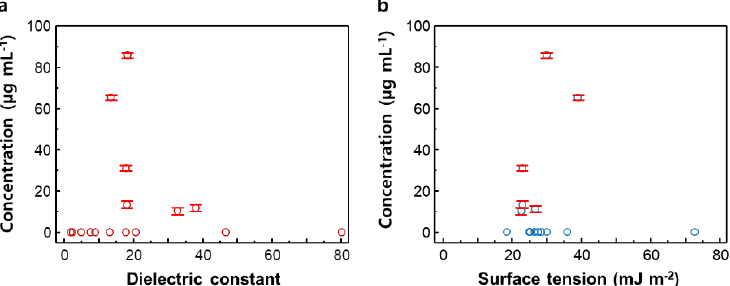
Figure 3. Concentration of the Nb 2 Se 9 dispersion solution versus ( a ) dielectric constant and ( b ) surface tension Error bars represent standard deviations obtained from three measurements of the same sample.